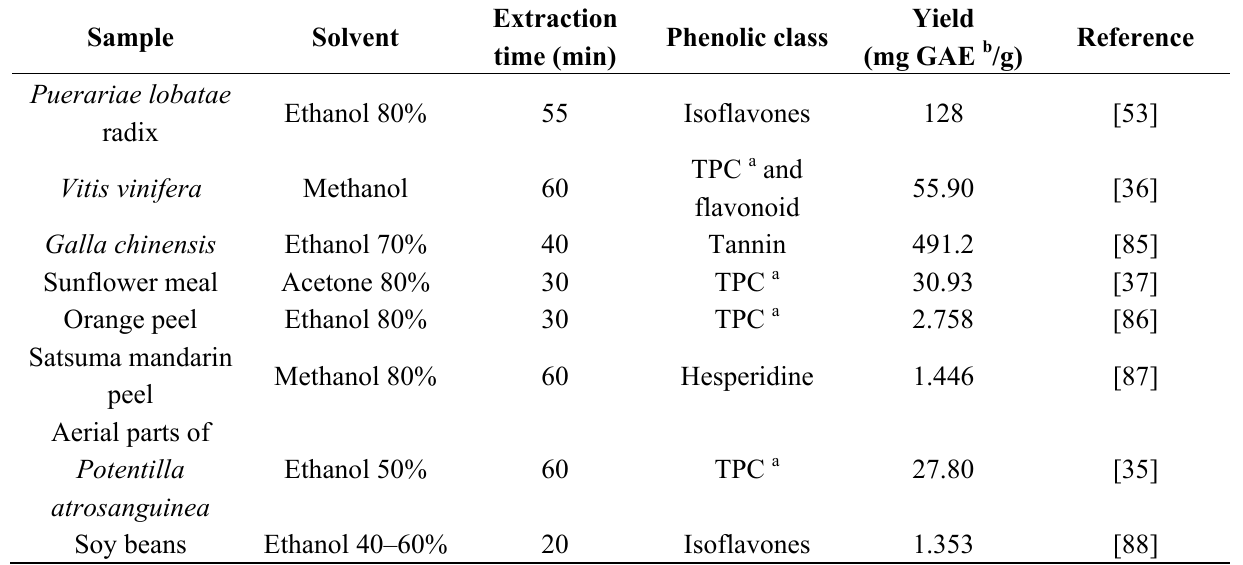
Table 1. Extraction of biologically active compounds using